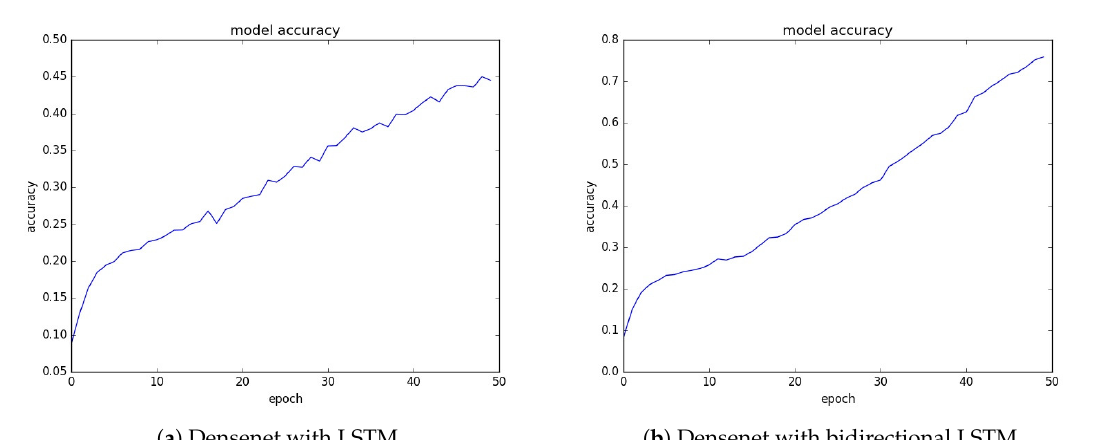
Figure 5. Comparison of the accuracies of different